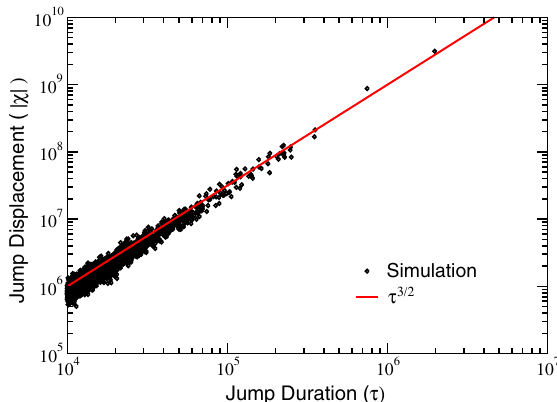
FIG. 3. We plot the flight distance j χ j versus the jump duration τ to demonstrate the strong correlations between these two random variables. Here, D ¼ 2 = 3 , and the red line has a slope 3 = 2 reflecting the χ ∼ τ 3 = 2 scaling discussed in the